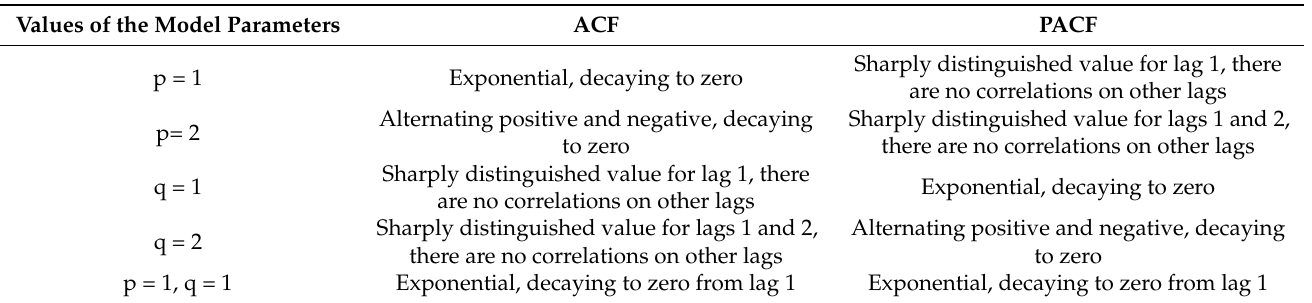
Table 1. Determination of model parameters via autocorrelation function (ACF) and partial autocorrelation function (PACF) figures.